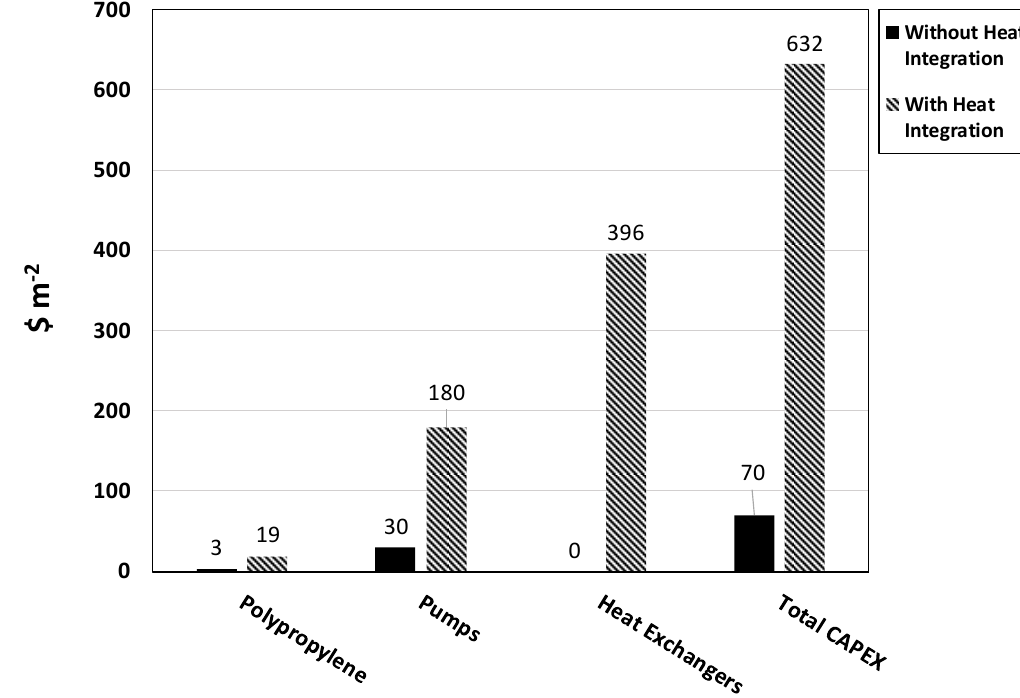
Figure 12. Capital expenditures (CAPEX) for a PBR system with and without installed heat integration equipment. Both PBR systems were sized for a 1 MW power plant. Capital costs ($ m − 2 ) were calculated assuming a baseline production cost of $70 m − 2 , which includes the cost of equipment.